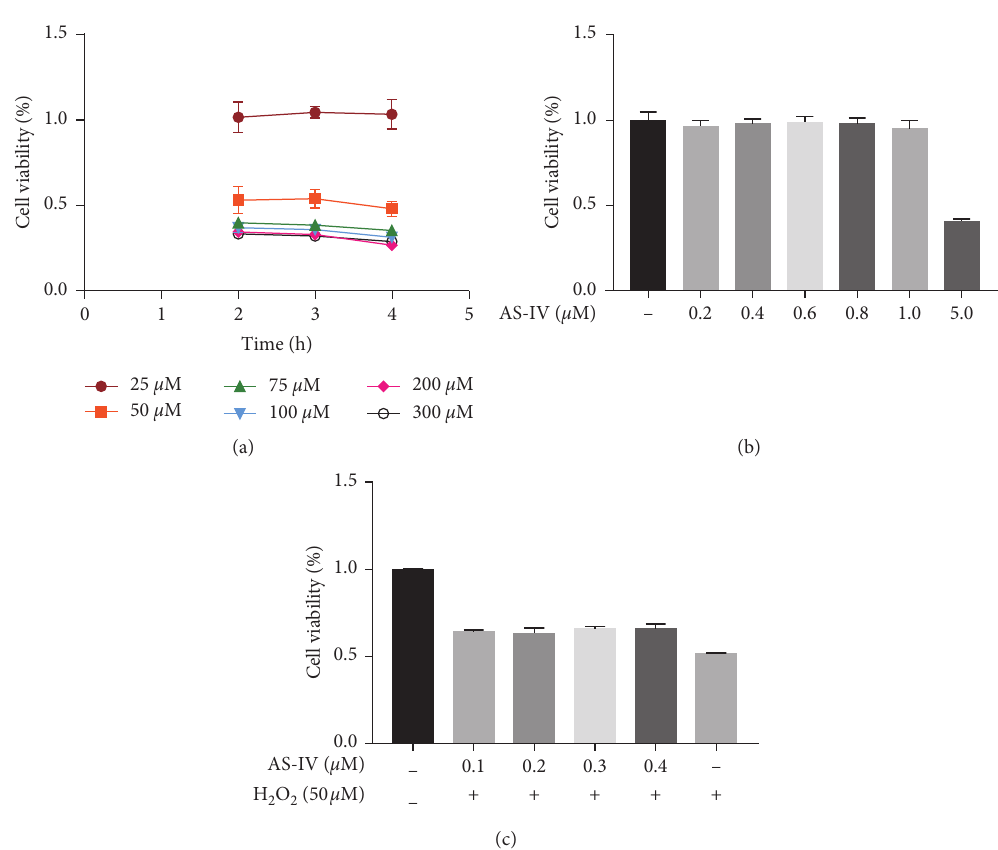
Figure 1: MTTassay for SH-SY5Y cells viability: (a) viability detection of SH-SY5Y cells treated with H 4h. (b) Viability detection of SH-SY5Y cells treated with AS-IV (0.2 ∼ 5 μ mol · L − 1 ) for 24h (c) Viability detection of SH-SY5Y cells under H 2 O 2 (50 μ mol · L − 1 ) treatment for 3h after AS-IV (0.1 ∼ 0.4 μ mol · L − 1 ) pretreatment for 2